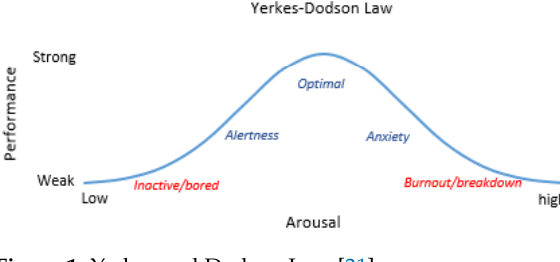
Figure 1. Yerkes and Dodson Law